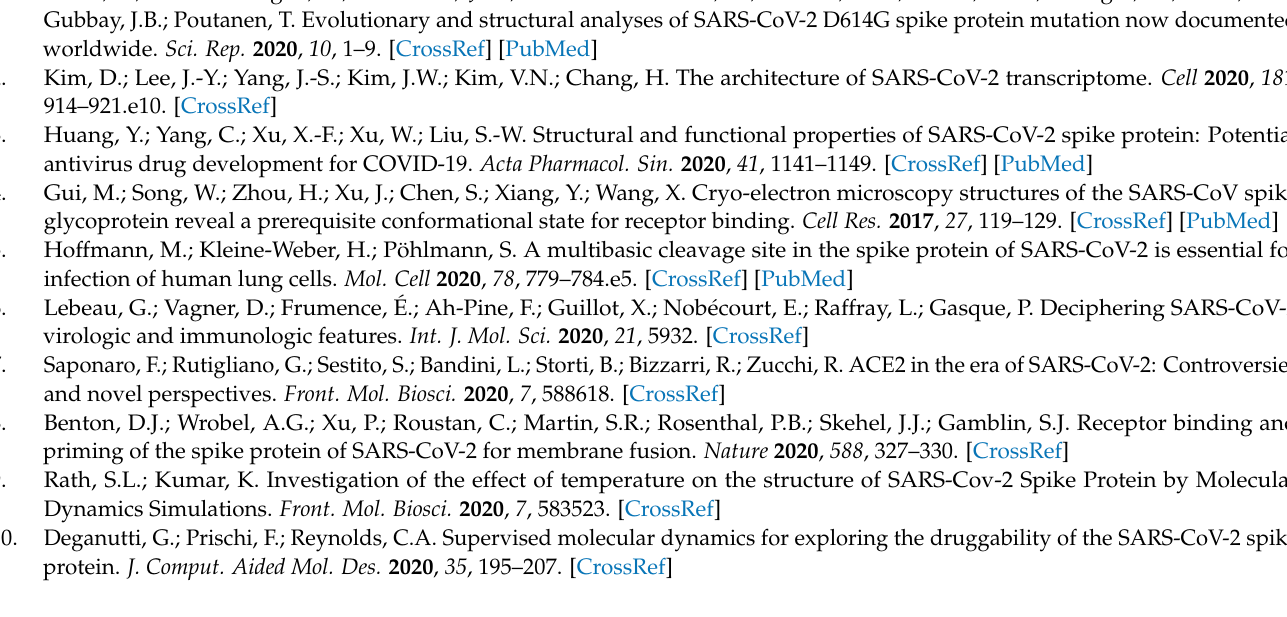
Table S1. The RMSD value within a chain of S protein (nm). Table S2. Summary for distance and S.D between V503 residues